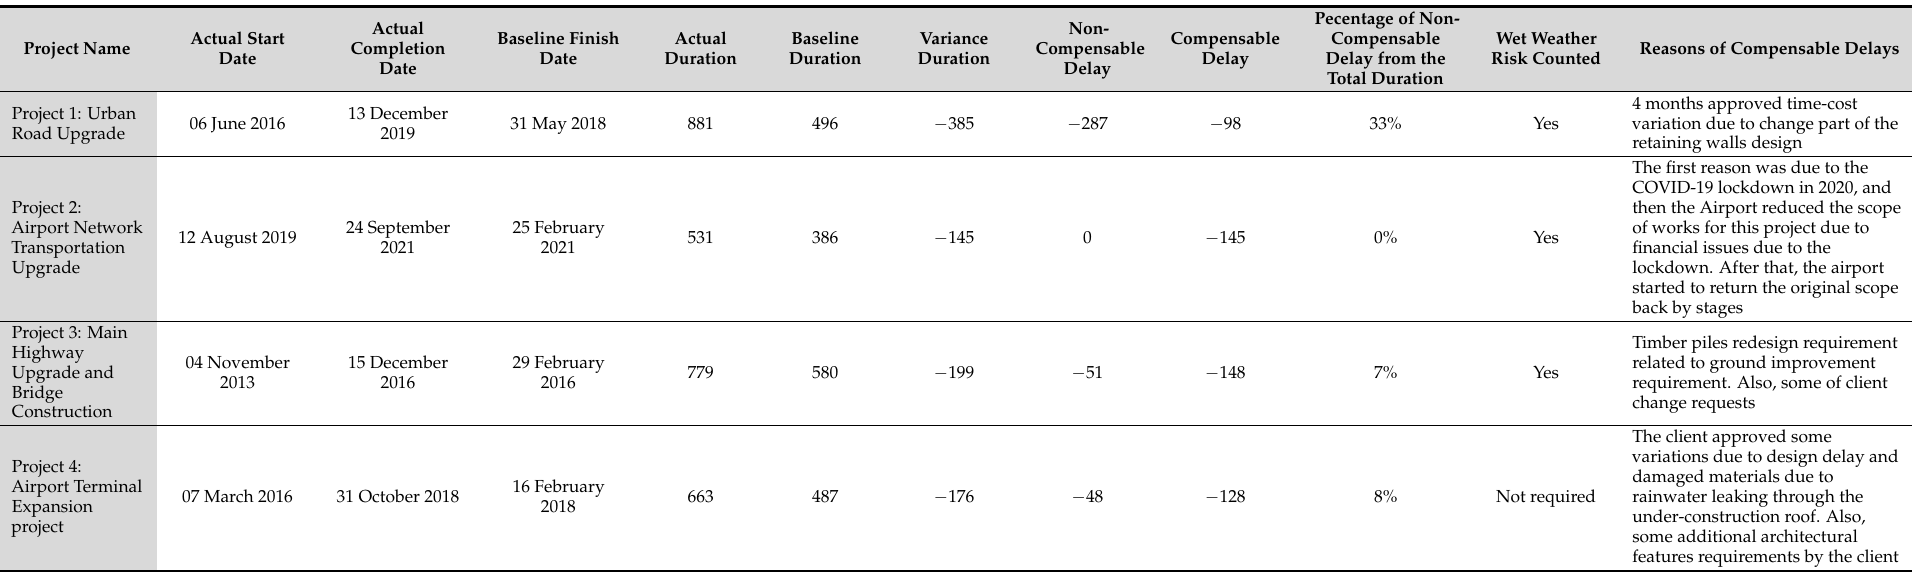
Table 1. Projects case studies performance